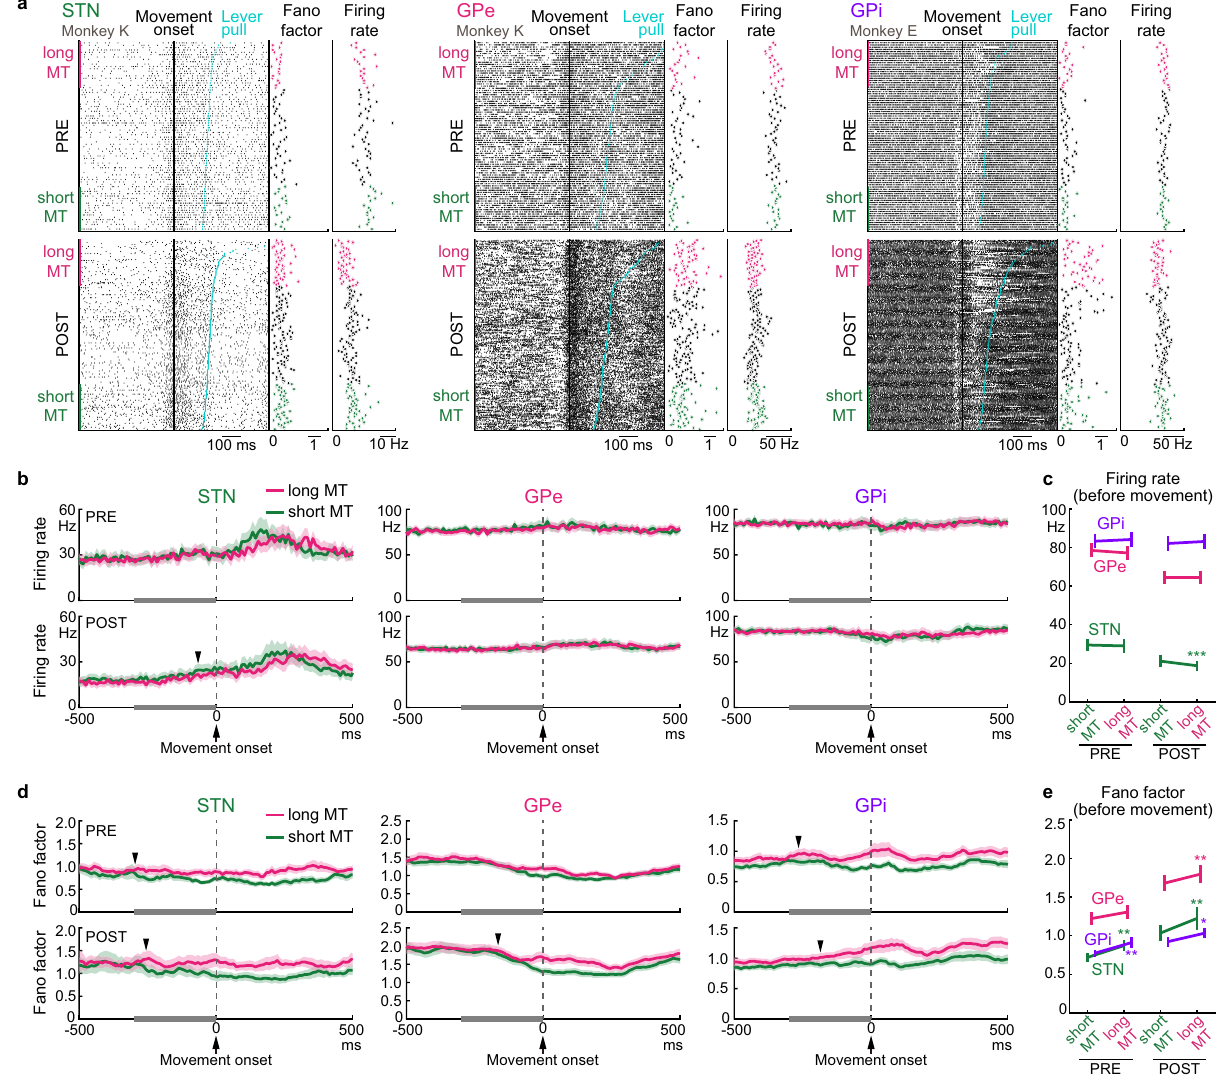
Fig. 5 Neural activity correlated with disturbance in reaching movements after reduction of STN activity. a Examples of STN/GPe/GPi neuronal activity with the Fano factor and Firing rate calculated in each trial. Spikes are aligned with Movement onset, and trials are sorted by MTs. In each neuron, the short- and long-MT trials were de fi ned as trials with MTs below the 25th and above the 75th percentile, respectively. Both ET and SI trials were combined. b Population-averaged Firing rates of 35 STN, 78 GPe, and 80 GPi neurons (with ≥ 10 short- and long-MT trials) for the short- and long-MT trials in the PRE and POST periods. Solid lines and shading indicate mean and SEM, respectively. Arrowheads indicate onsets of signi fi cant changes between short- and long-MT trials. Bin width, 10 ms. c Firing rate difference of 35 STN, 78 GPe, and 80 GPi neurons between short- and long-MT trials during the 300 ms preceding Movement onset, indicated by gray horizontal lines in b . STN neurons showed low fi ring rate in long-MT trials of the POST period ( P = 0.0009; two-tailed Wilcoxon-signed rank test). d Population-averaged Fano factor of 35 STN, 78 GPe, and 80 GPi neurons for the short- and long-MT trials in the PRE and POST periods. Solid lines and shading indicate mean and SEM, respectively. e Fano factor difference of 35 STN, 78 GPe, and 80 GPi neurons between short- and long-MT trials during the 300 ms preceding Movement onset. High Fano factor in long-MT trials in the STN and GPi ( P = 0.002 and 0.009, respectively; two-tailed Wilcoxon-signed rank test) during the PRE, and in the STN, GPe, and GPi ( P = 0.002, 0.007, and 0.01) during the POST. Error bars indicate SEM. * P < 0.05, ** P < 0.01, *** P <